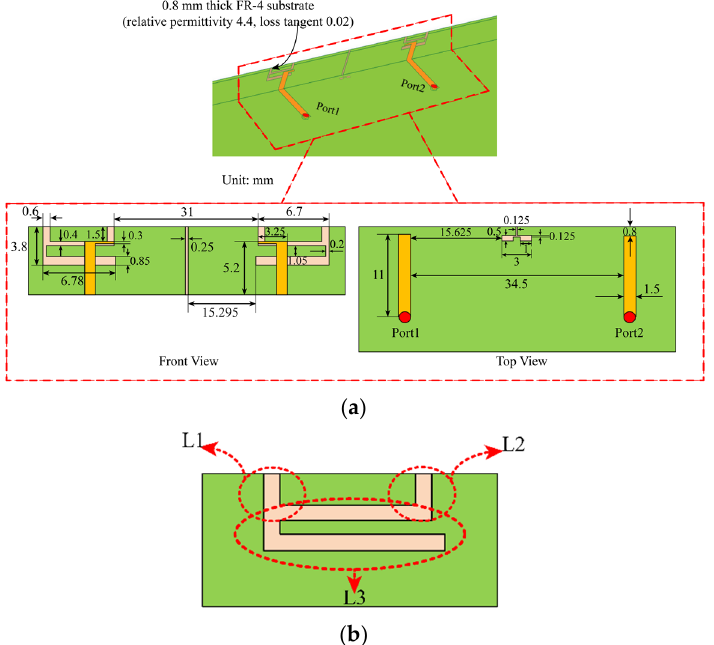
Figure 2. Detailed dimensions of the antenna element. ( a ): Inverted L-shaped microstrip line and de-coupling element and ( b ): no optimized antenna element.